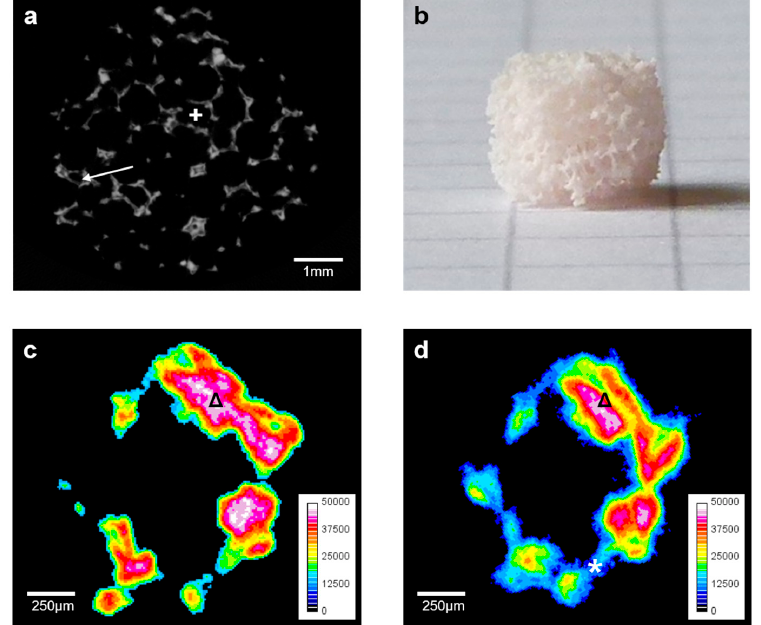
Figure 1. Characterization of Group A scaffolds: representative 2D-µCT-image ( a ); a photograph of the scaffold (edge length of the squares in the background: 5 mm) ( b ); 2D density color-coded µCT-